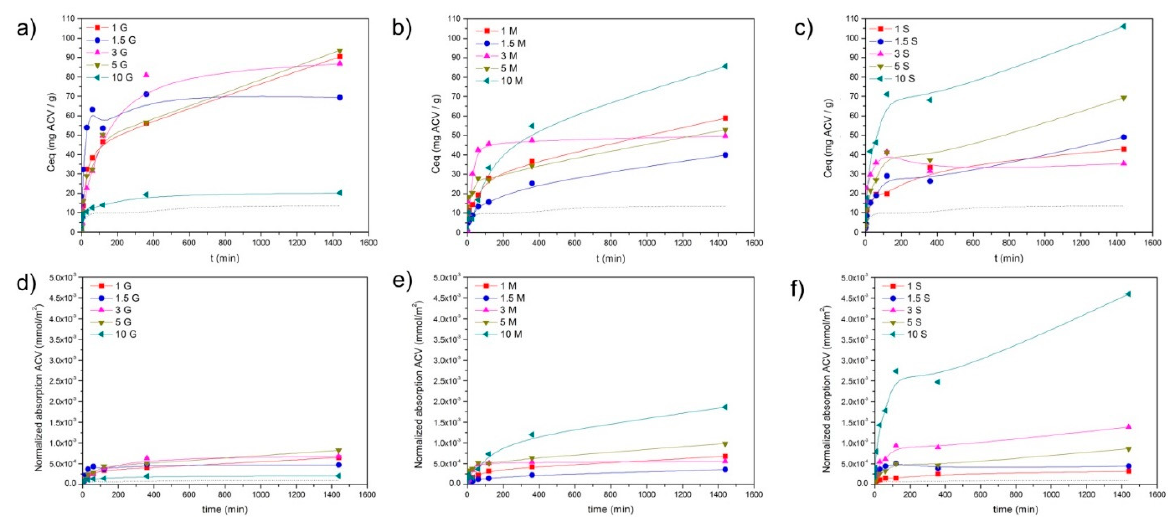
Figure 8. Ceq (in mg/g) of the mesoporous materials functionalized with ( a ) GLYMO, ( b ) MEMO, and ( c ) MPTMS. Dotted line corresponds to the nonfunctionalized mesoporous material. Normalized absorption of ACV (in mmol/m 2 ) with respect to the surface area of the materials functionalized with ( d ) GLYMO, ( e ) MEMO, and ( f ) MPTMS.